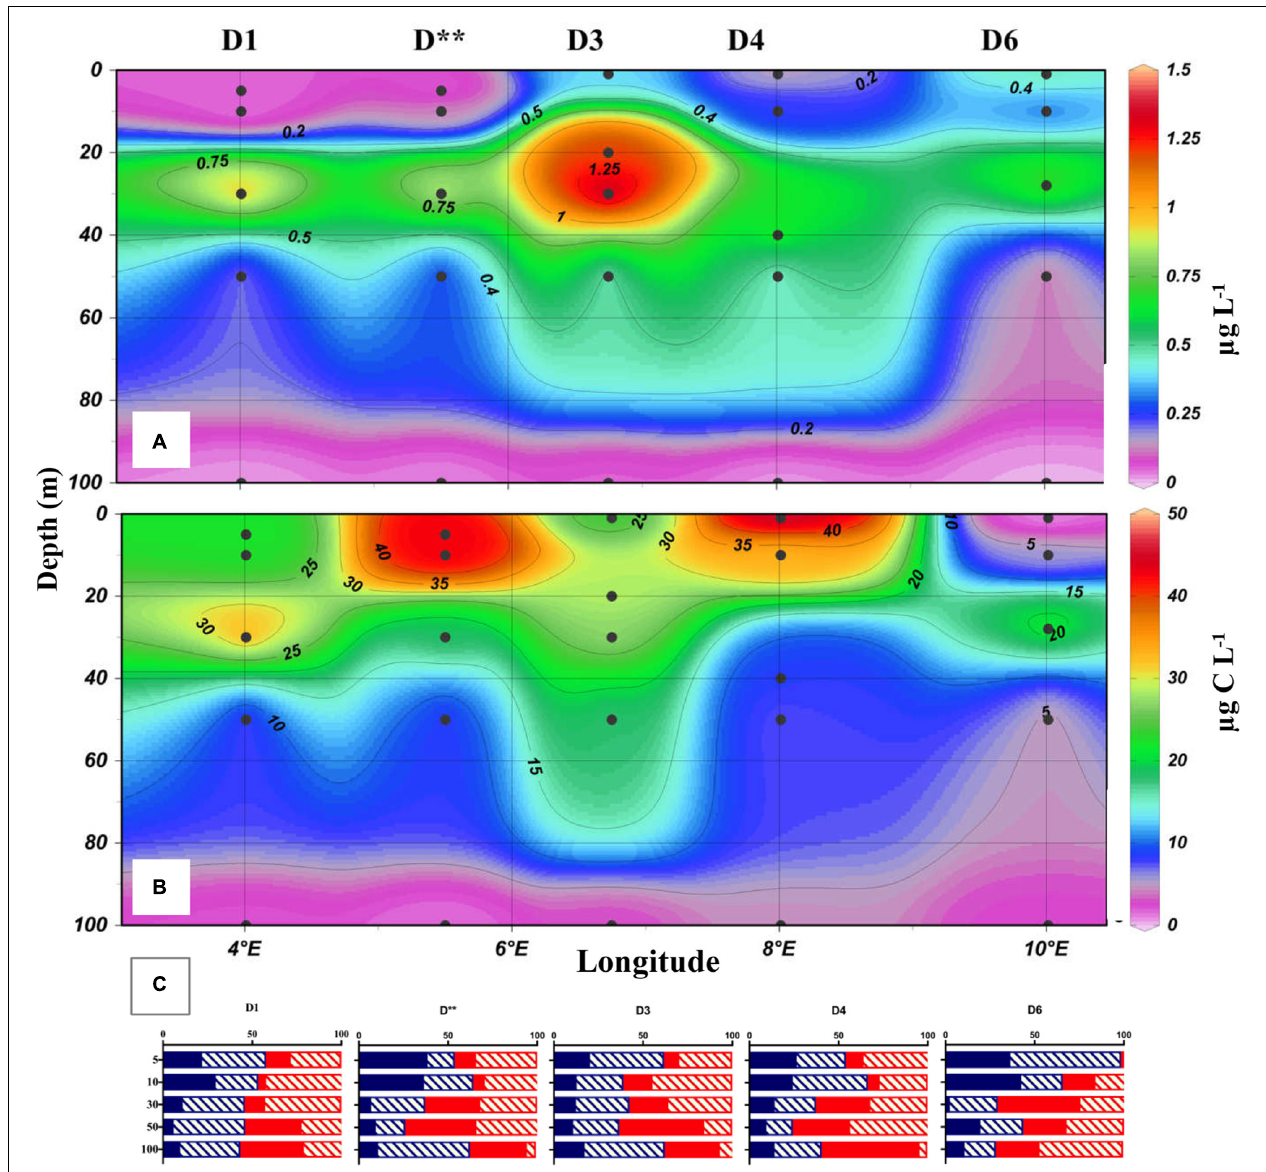
FIGURE 3 | The distribution of chlorophyll a (A) , microzooplankton biomass (B) , and the relative biomass (C) of different microzooplankton groups in the upper 100 m of the water column along the D transect during the August 2014 Carbon Bridge cruise. Microzooplankton group abbreviations as in Figure 2 .